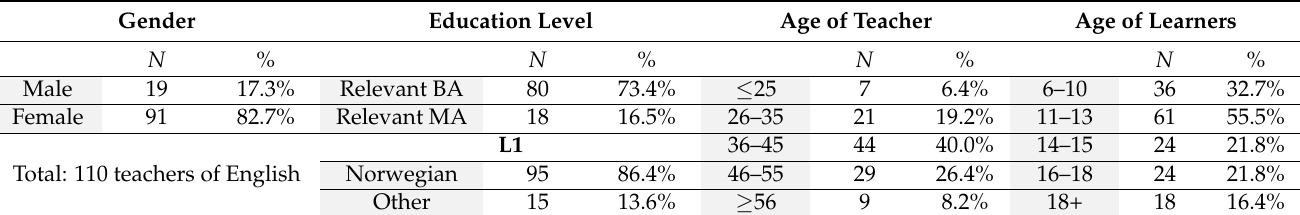
Table 1. Participant demographic